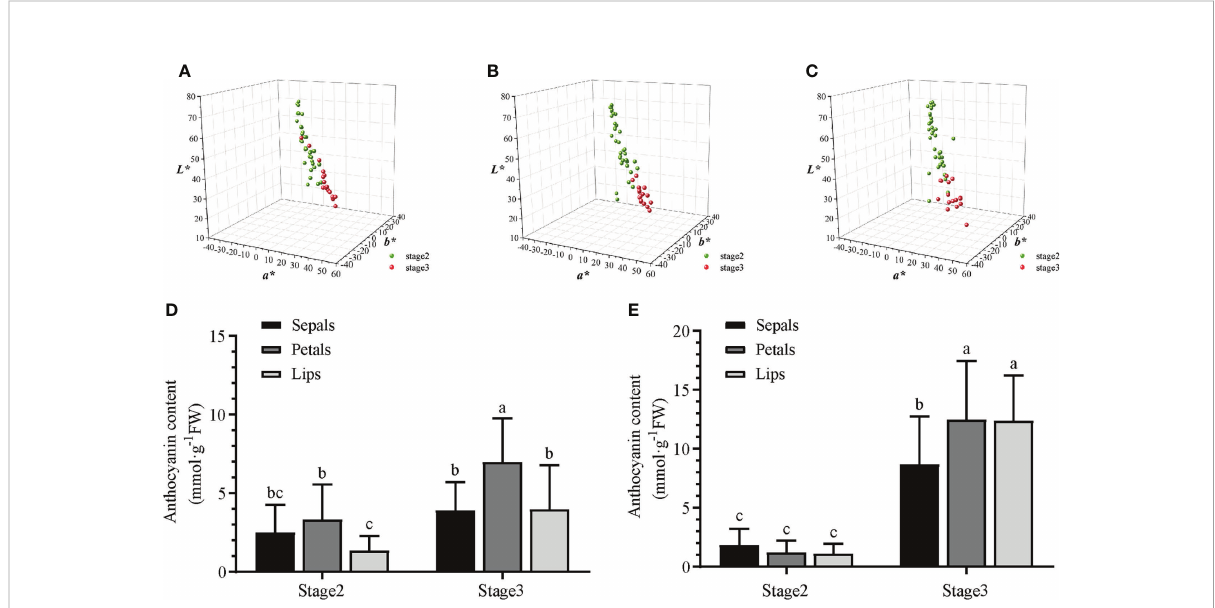
FIGURE 4 Analyses of color and total anthocyanin content in different fl oral tissues of two Dendrobium hybrid families during fl ower development. Colorimetric analyses of sepals (A) , petals (B) and lips (C) of “ ED ” hybrid progenies at different developmental stages in three-dimensional color space using the CIE L*a*b* system. Analyses of anthocyanin contents (mean ± SEM) in different fl oral tissues of “ ED ” hybrid progenies (D) or “ BP ” hybrid progenies (E) during fl ower development. Twenty F1 progenies of each hybrid family were used for analyses. Different letters indicate signi fi cant differences ( p < 0.05, Duncan ’ s multiple range